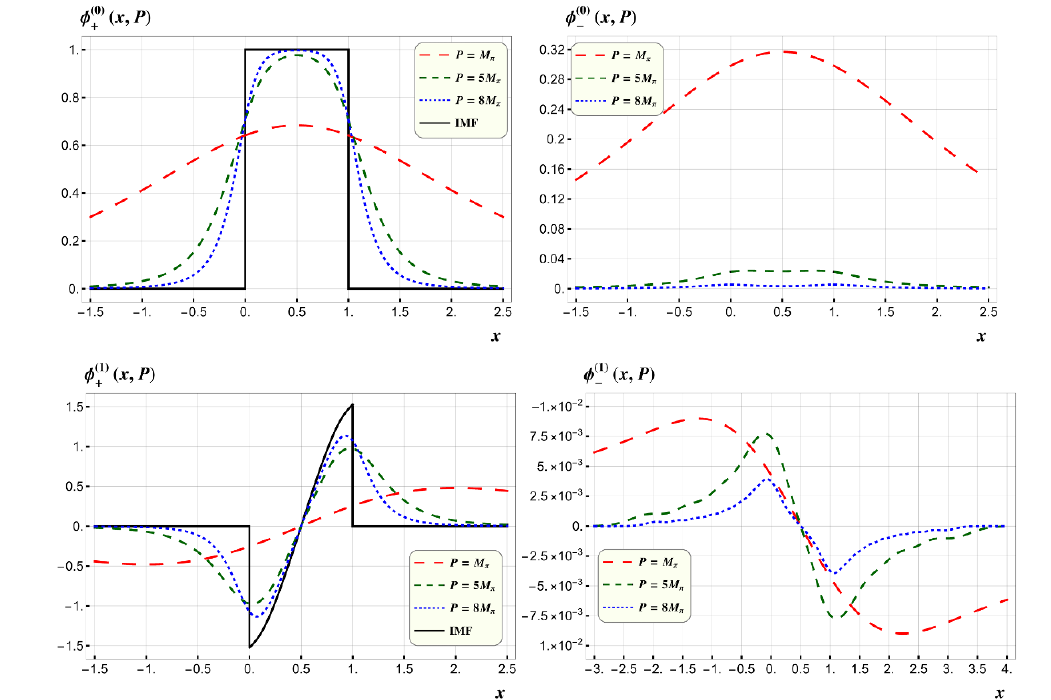
Figure 8 . Bars-Green wave functions for the low-lying u (cid:22) u states in the chiral limit: chiral pion (cid:25) (cid:31) ((cid:12)rst row), and the (cid:12)rst excited state (second row).